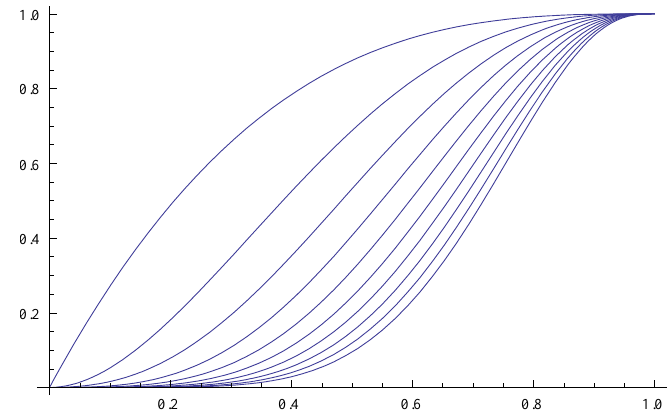
Figure 1. The reliability polynomial of the linear < n ,3,2> for n = 3,4,...,12.